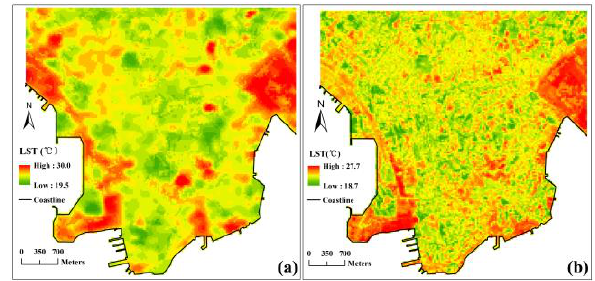
Figure 8. Comparison between simulated and actual spatial pattern of LST in